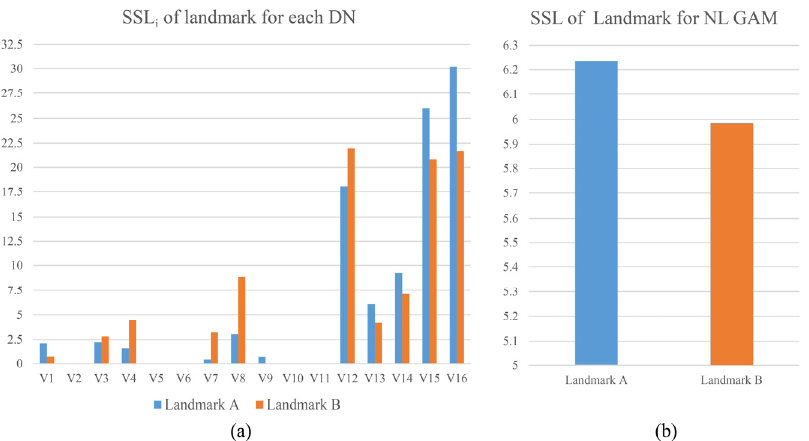
Figure 7. Structural salience of landmarks in the standard block. ( a ) Structural salience of landmarks corresponding to each decision node, ( b ) structural salience of landmarks in the grid.